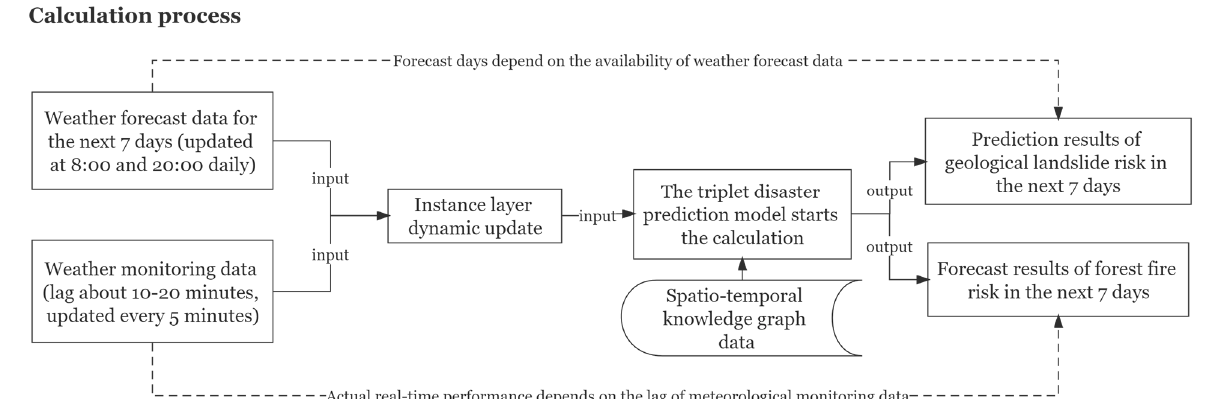
Figure 13. Workflow of disaster dynamic